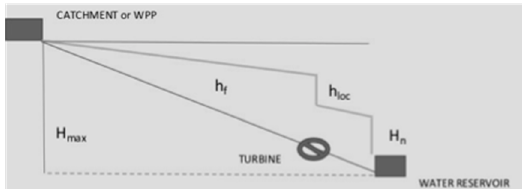
Figure 2. Scheme of turbine installation in WSS where the head considered are indicated: gross head (H max ), net head (H n ) and hydraulic friction losses (h f ) and local losses (h loc